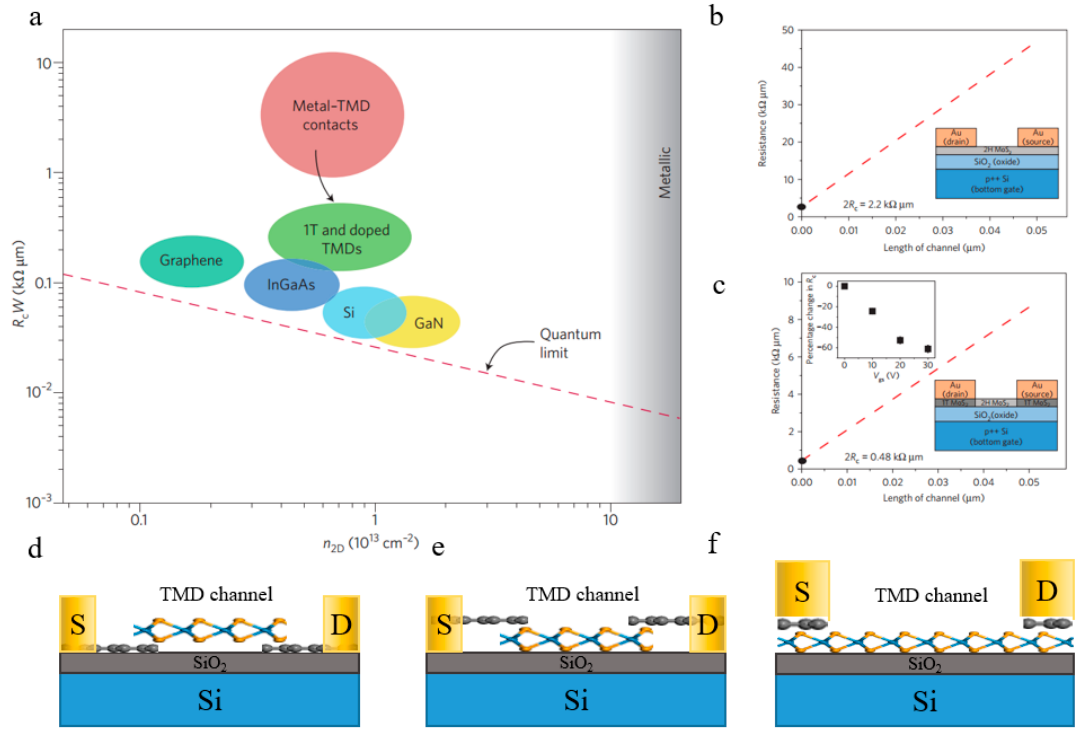
Figure 6. Contact resistance for different two-dimensional materials: ( a ) various contact resistance of materials against quantum limits; Reused with the permission from Nature publishing Group in the Ref [65] ( b ) contact resistance with traditional 2H-MoS 2 material; ( c ) contact resistance with 1T-MoS 2 and 2H MoS 2 as channel material; ( d ) coplanar contacts of graphene electrodes; ( e ) staggered contacts of graphene electrodes; and ( f ) hybrid contacts of graphene electrodes. ( b , c ) are reproduced with the permission from Nature publishing Group in the Ref [67]. ( d – f ) are adapted with the permission from Nature publishing Group Ref [5].